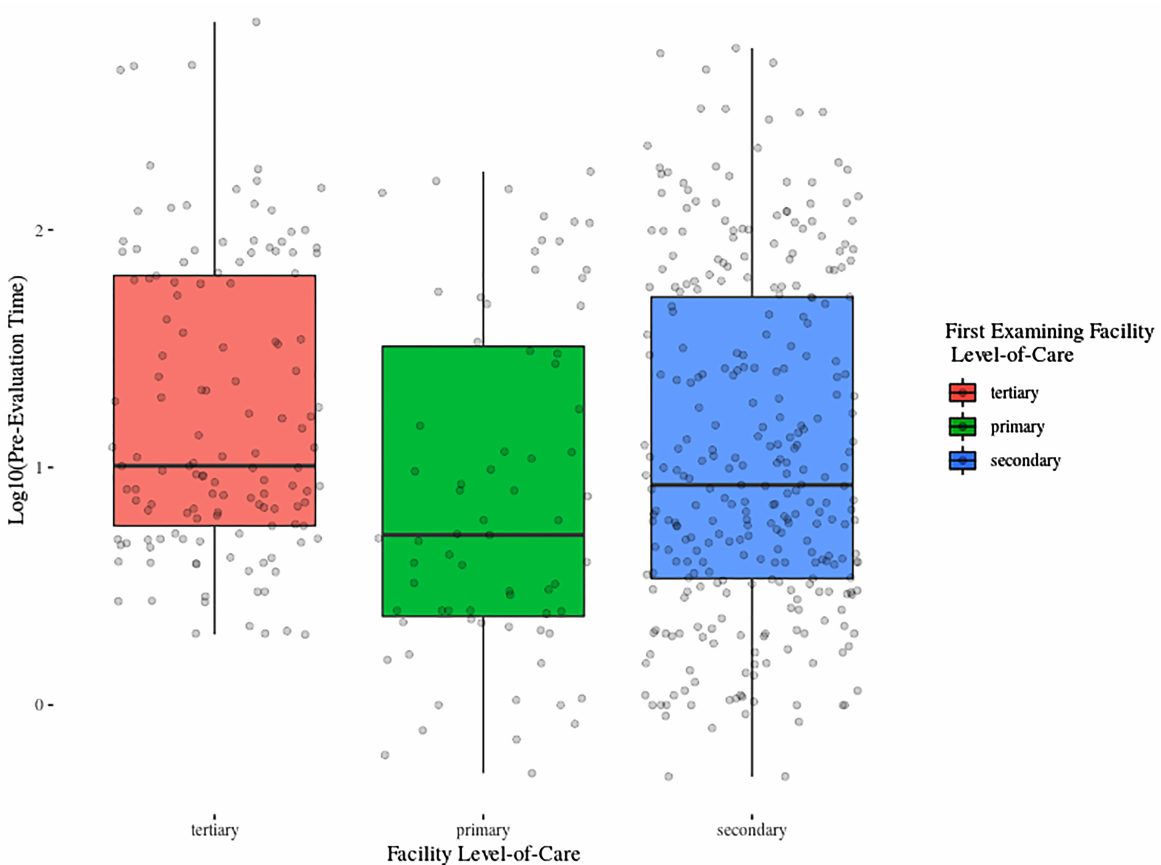
Figure 2 - Presentation delay (log10 transformed) according to the first examining facilitie’s